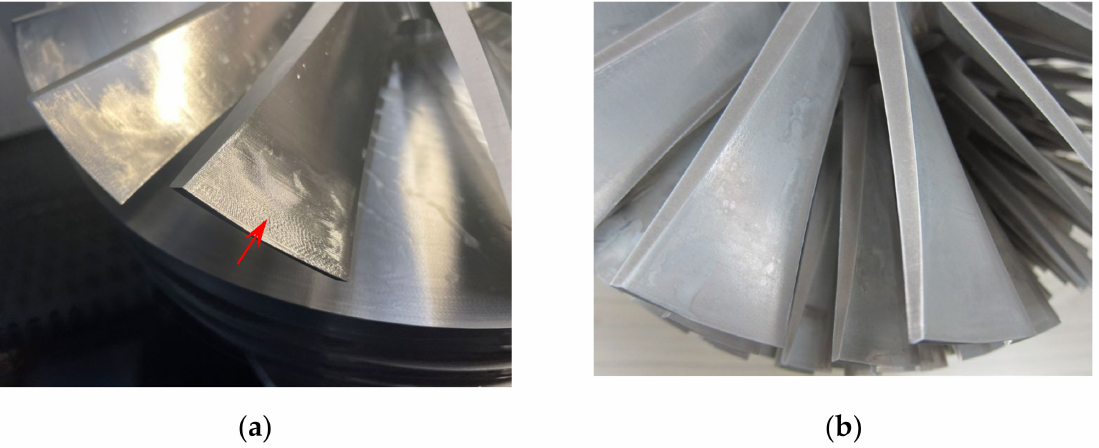
Figure 11. Chatter results can be suppressed or solved when the RP blocks are stuffed between the blades in finishing. ( a ) Chatter occurs on the blade surface, as indicated by the arrow; ( b ) better surface quality on the blade surface.